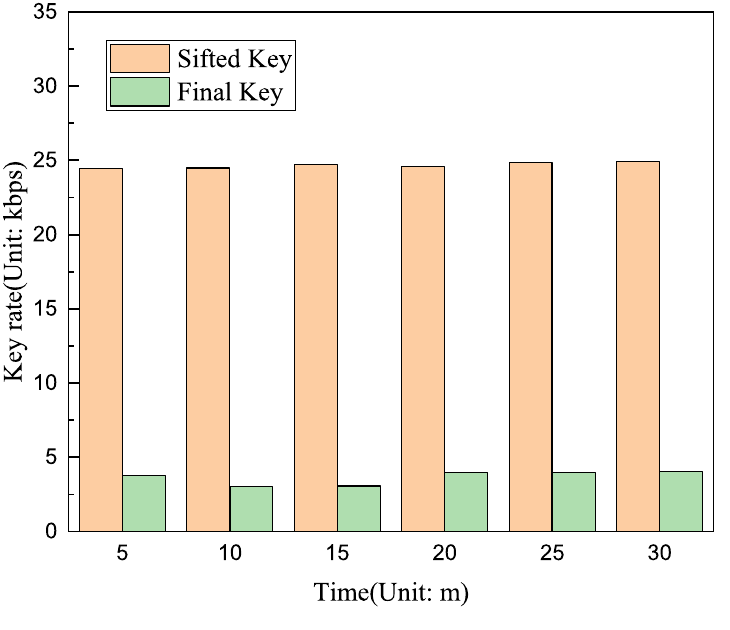
Figure 10. The quantum key rate.